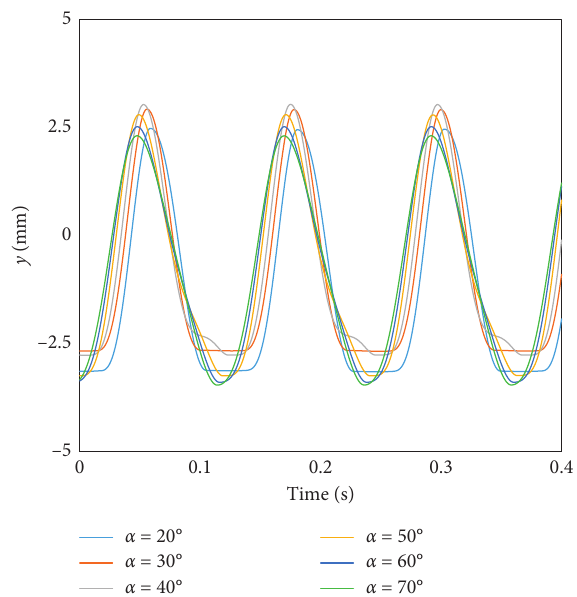
Figure 18: The influence of wedge angle on the response of the suspension system when excitation amplitude � 15mm and frequency �